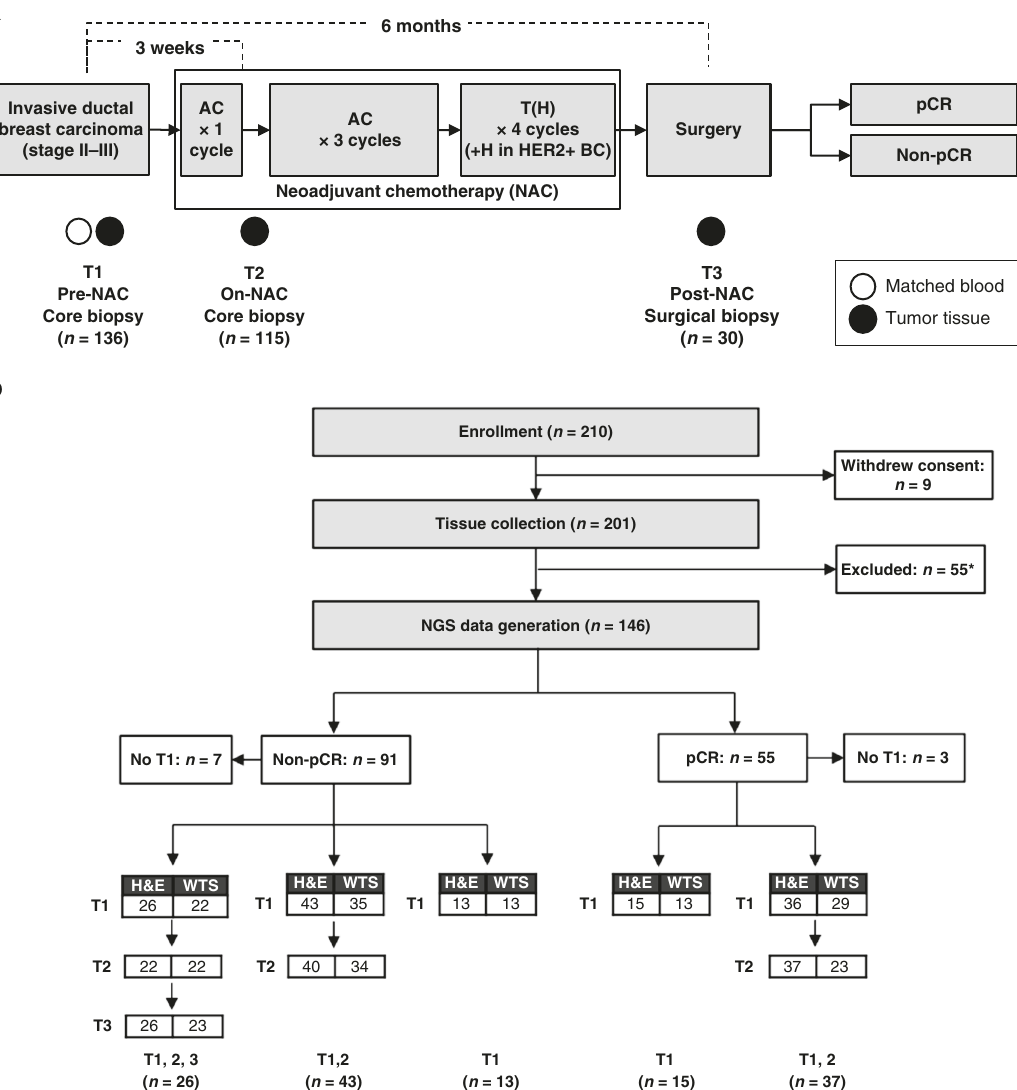
Fig. 1 Study design and consort diagram. a Study design diagram. AC Adriamycin (Doxorubicin) + Cyclophosphamide, T Taxol (Docetaxel), H Herceptin (Trastuzumab), NAC neoadjuvant chemotherapy, pCR pathologic complete response. ( b ) Consort diagram for patient enrollment, sample collection and data generation. Tissues were not collected for nine patients who withdrew consent. *55 patients were excluded from NGS data generation due to tissue collection failure (33), follow-up failure (7), withdrawal of consent (6), non-breast cancer pathology (4), distant progression and exclusion from surgery (3), NAC termination (1) and expiration (1). Two non-pCR patients had paired T1, T3 samples. WTS whole transcriptome